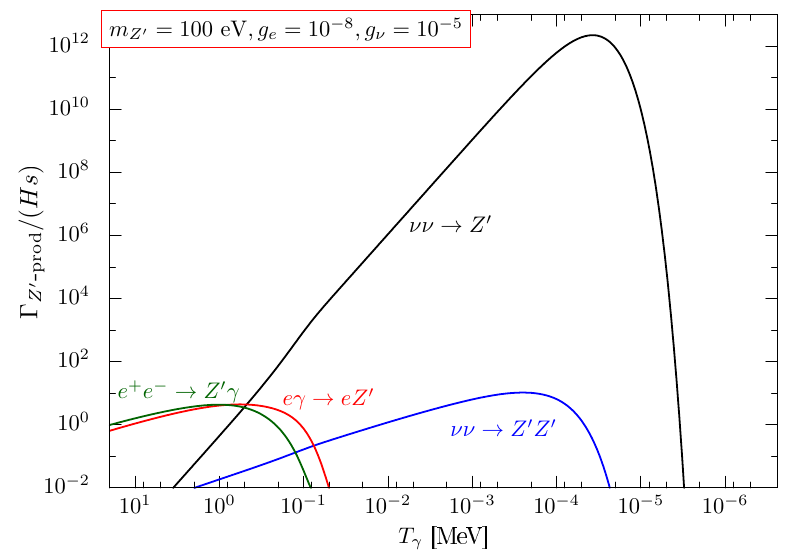
Figure 2. The temperature dependence of the production rates of the modes eγ → eZ 0 (red), e + e − → Z 0 γ (green), νν → Z 0 (black) and νν → Z 0 Z 0